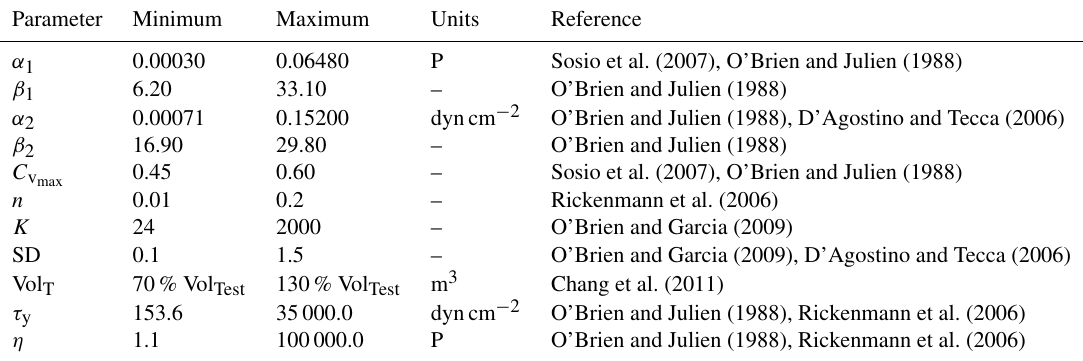
Table 1. Values range of the model parameters. P: poise; dyn: dyne. Parameter